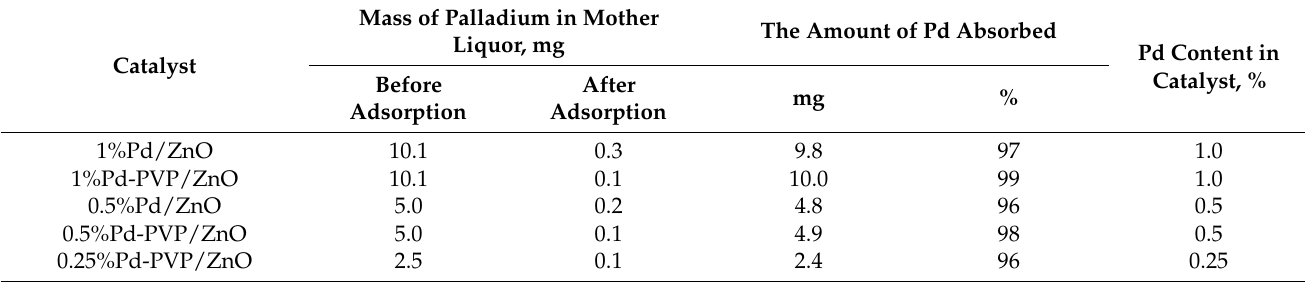
Table 1. Immobilization of Pd 2+ ions on PVP-modified zinc oxide precipitated from water solution.